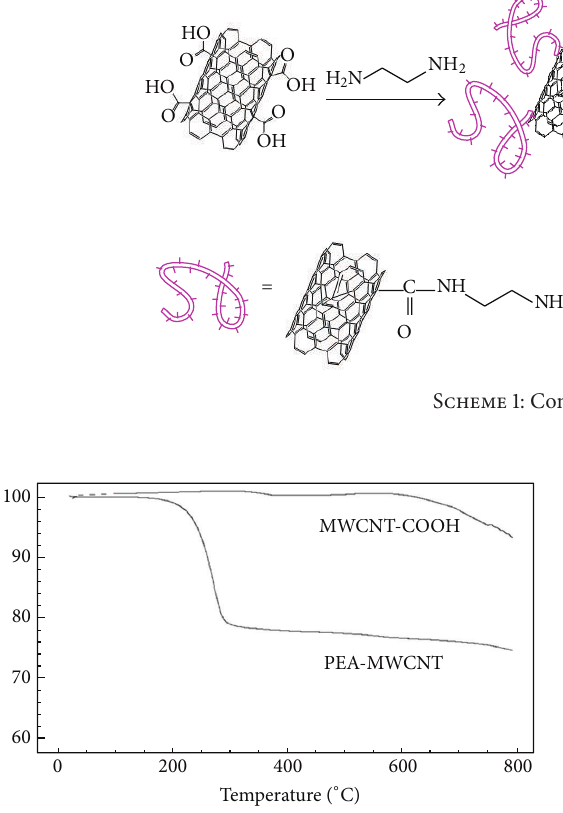
Figure 1: TGA thermograms of MWCNT-COOH, PEA-MWCNT.